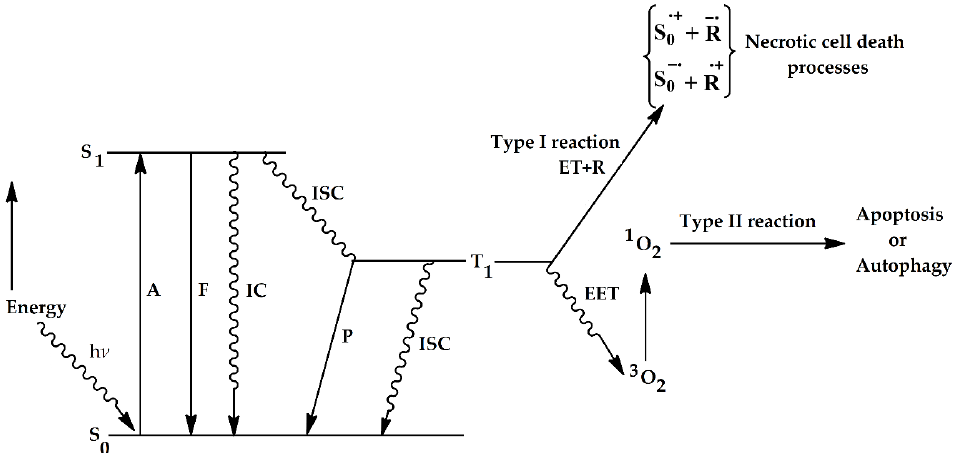
Figure 2. A diagram, illustrating the various changes in energy levels, which provide the physical and molecular basis for photodynamic therapy (PDT) (adapted from [25]). 1 O 2 : singlet oxygen, 3 O 2 : triplet oxygen, A = absorption of photons, F = fluorescence (emission), P = phosphorescence S = singlet state, T = triplet state, IC = internal conversion, ISC = intersystem crossing, EET = energy transfer through excitation, and ET = transfer of electrons, R = substrate.